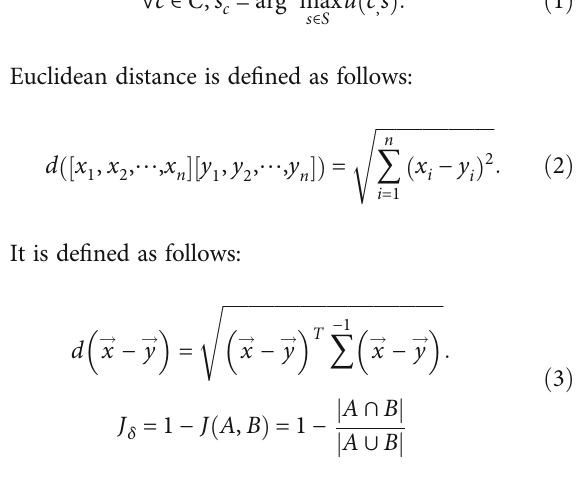
ffiffiffiffiffiffiffiffiffiffiffiffiffiffiffiffiffiffiffiffiffiffiffi